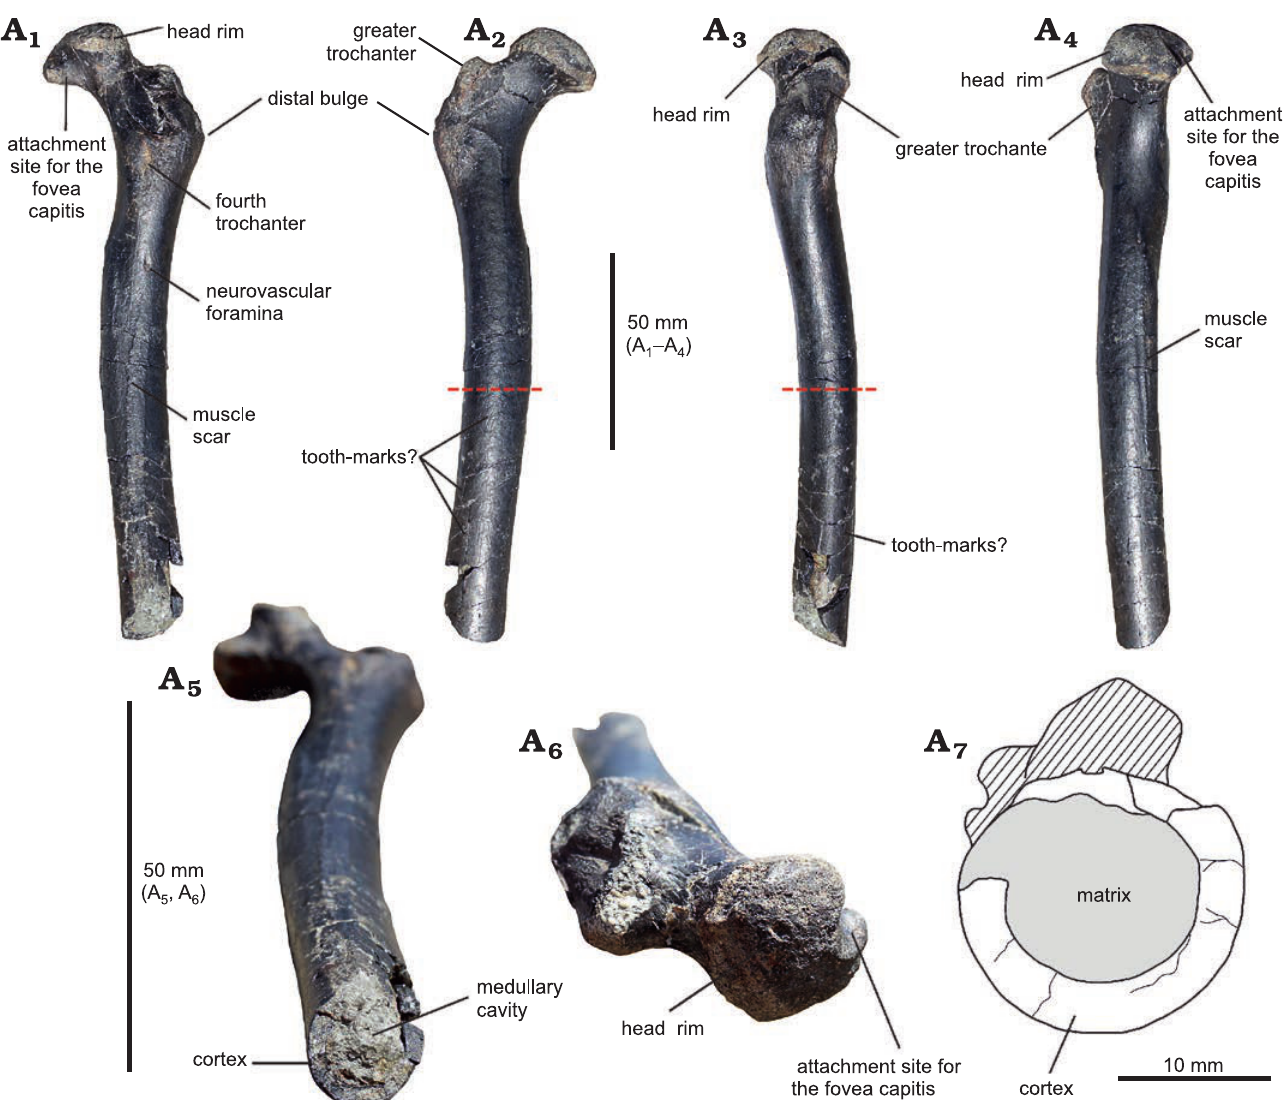
Fig. 2. A partial proximal right femur of a large indeterminate dsungaripteroid pterosaur (SHN.013) from the Kimmeridgian, Upper Jurassic, Praia da Armoreira-Porto Novo Formation, Peniche, Portugal. In ventral (posterior) (A 1 ), dorsal (anterior) (A 2 ), medial (A 3 ), lateral (A 4 ), distal (A 3 ), and proximal (A 6 ) views; A 7 , drawing of the distal end showing the thickness of the cortex compared to the lumen. Note that the sketch is about twice the scale of the images. The red dashed lines in A 2 and A 3 indicate the site where the histological section was